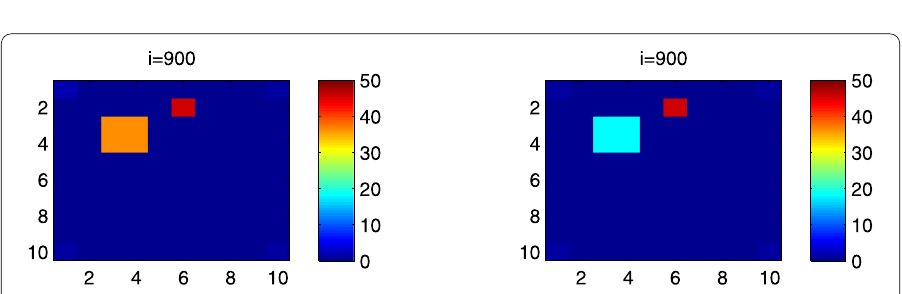
Figure 14 S Cpq behavior at the final instant i = 900 in the presence of optimal controls characterized in (11) with a travel-blocking vicinity optimal control strategy followed in the two patches P and P (cid:2) = { C 26 } . On the left side, the case when the disease starts from the corner cell C 1010 . On the right side, the case when the disease starts near the center of (cid:2) , exactly at C 65